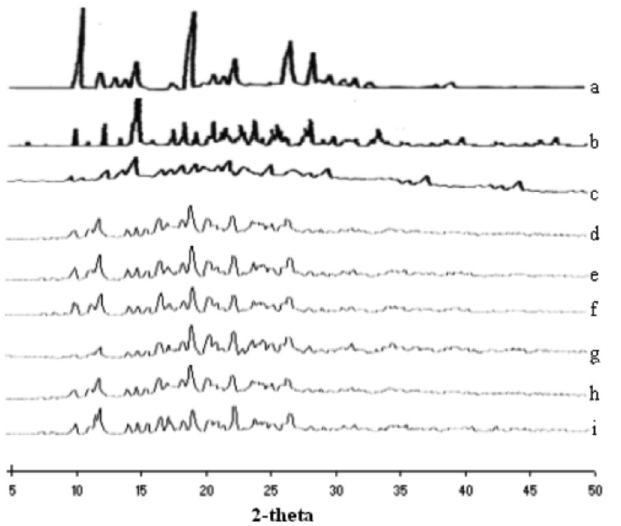
FIGURE 6 - DSC study of pure nifedipine(a); pure β-CD (b); physical mixture (c); coevaporation complex (d); kneading complex (e); cogrounding complex (f); freeze drying complex (g); spray drying complex (h); melting complex